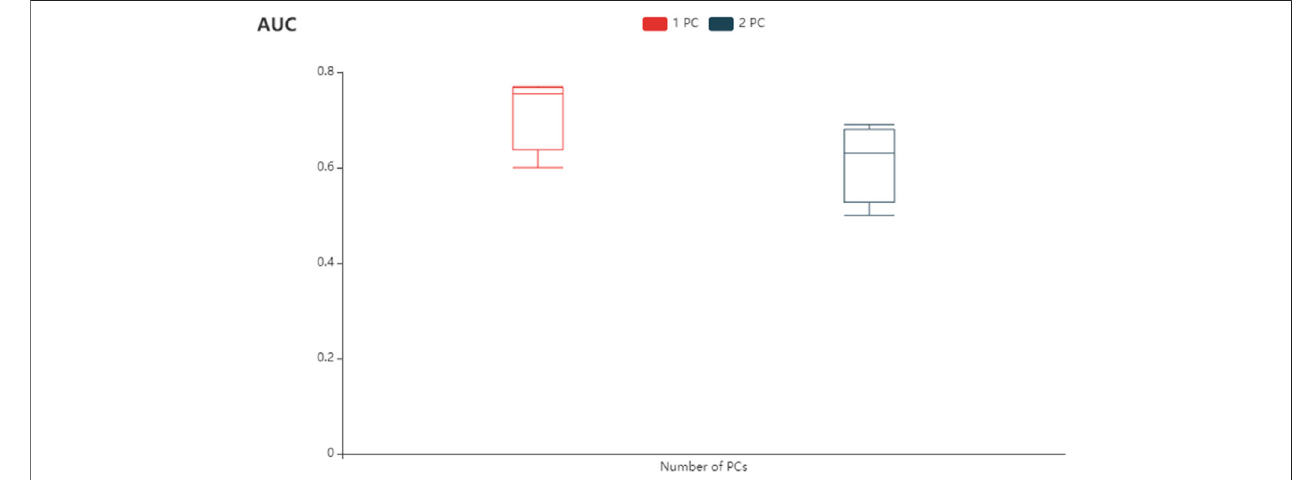
FIGURE 3 | Modeling performance.